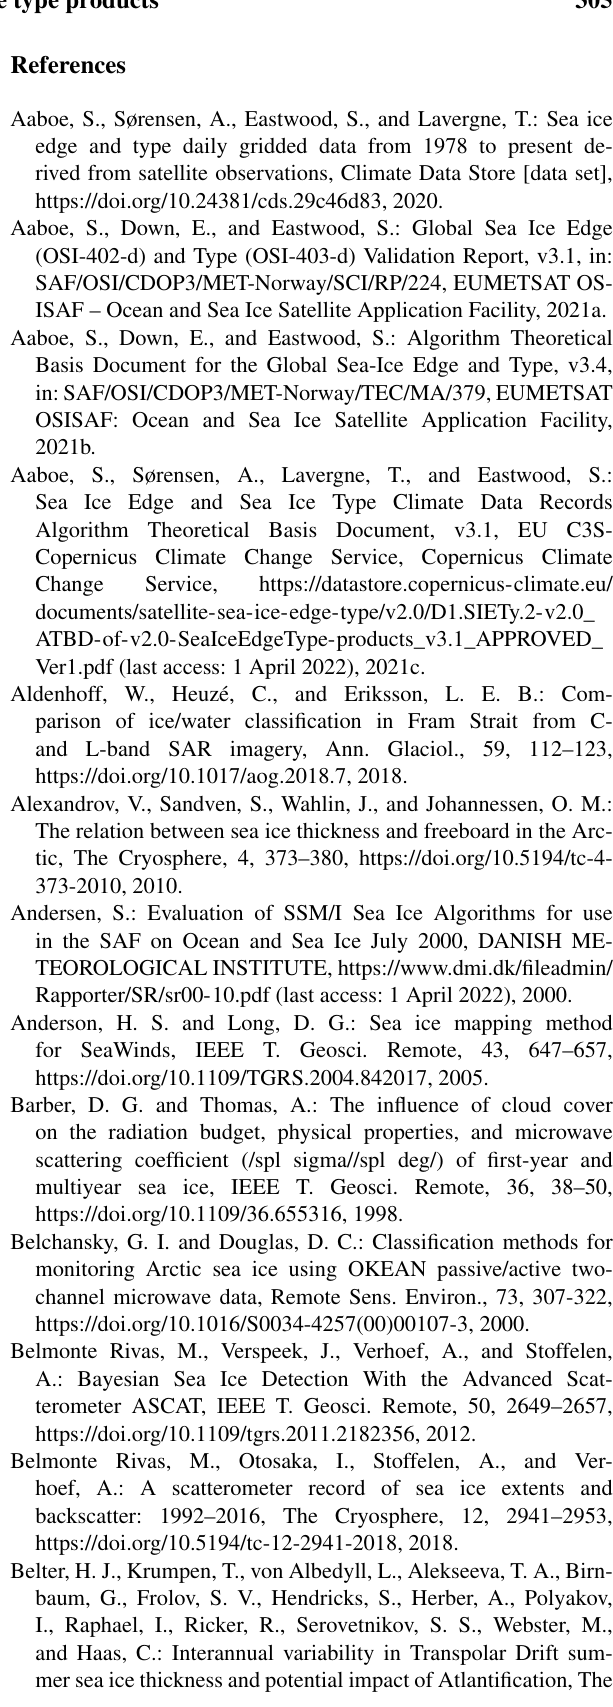
Algorithm Theoretical Basis Document, v3.1, EU